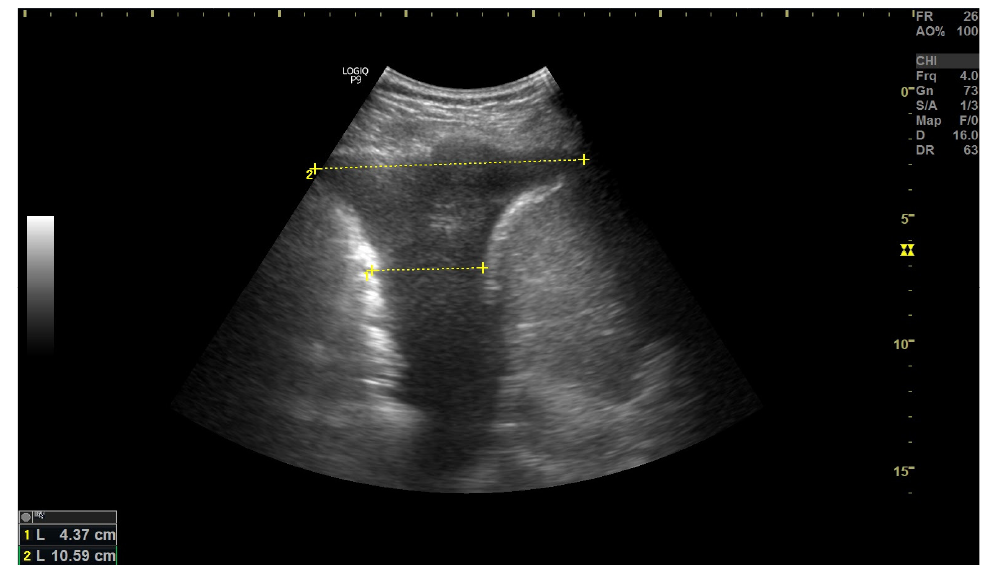
Figure 8. A small amount of simple fluid in the pleural cavity. Height of the effusion and distance between the lung base and diaphragm are measured. Figure were acquired in the Department of Internal Medicine, Pulmonary Diseases and Allergy, Medical University of Warsaw.